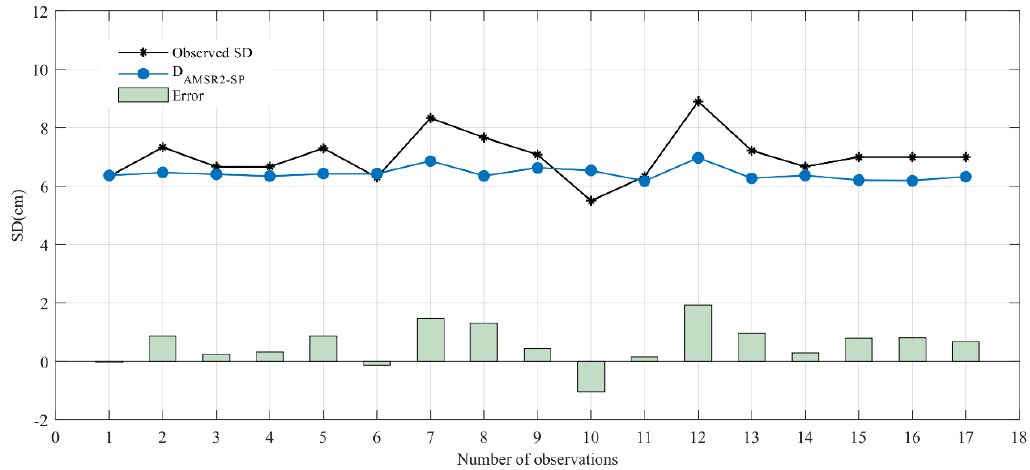
Figure 4. The SD spatial distribution on 23 January 2018 in Northeast China. ( a1 ) AMSR2 (25 km × 25 km); ( b1 ) D AMSR2-product (500 m × 500 m). ( a2 , b2 ) represent the corresponding SD map. The black triangles represent snow observations within the snow quadrat with a spatial resolution of 500 m.